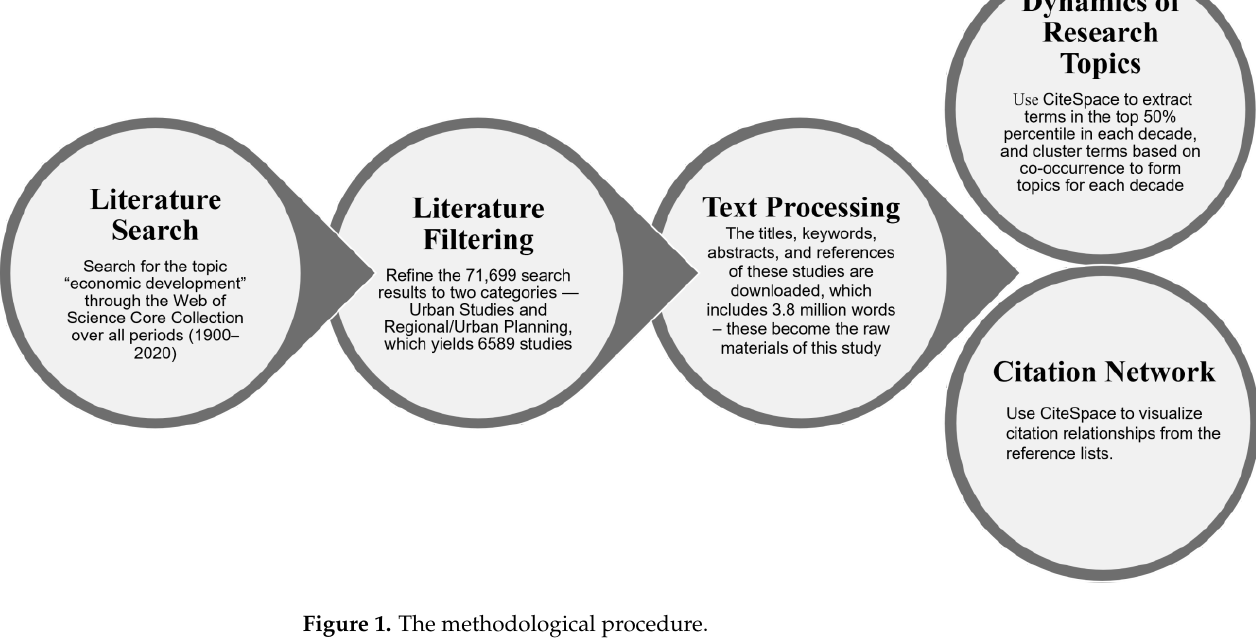
Figure 1. The methodological